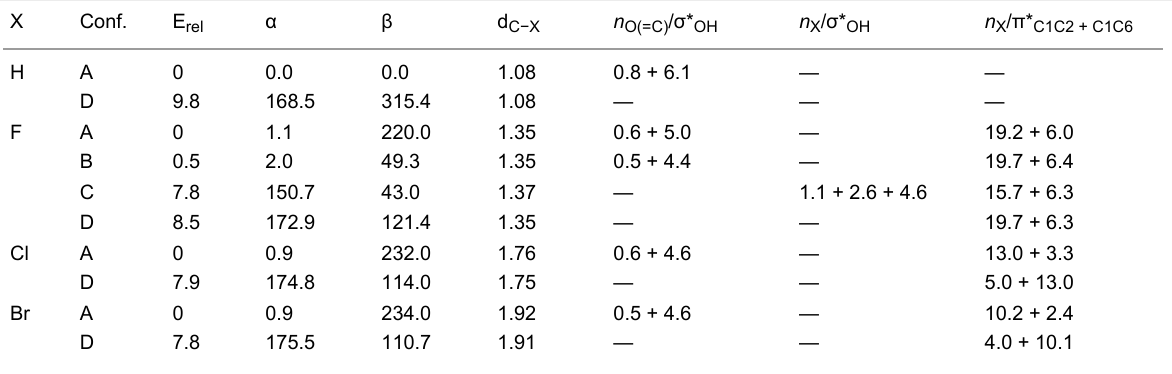
Table 1: Conformational energies (kcal mol − 1 ), geometrical parameters ( α and β torsional angles in degrees, and C–X distance in angstroms), and selected NBO electron delocalization (kcal mol − 1 ) for 2'-haloflavonols. X Conf.